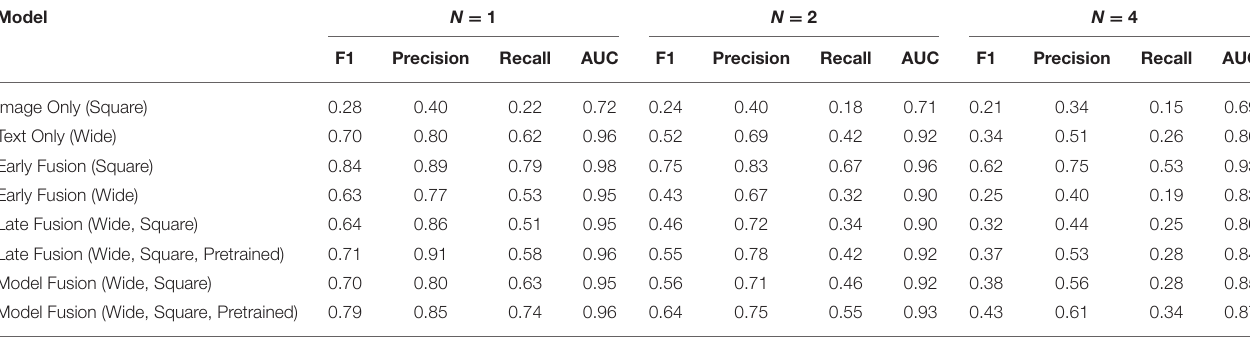
TABLE 2 | Average F1, precision, recall, and AUC scores of every model for each n performed 5 times and averaged together for the Indiana Chest X-Ray dataset. Model N = 1 N = 2 N = 4 F1 Precision Recall AUC F1 Precision Recall AUC F1 Precision Recall AUC Image Only (Square) Text Only (Wide) Early Fusion